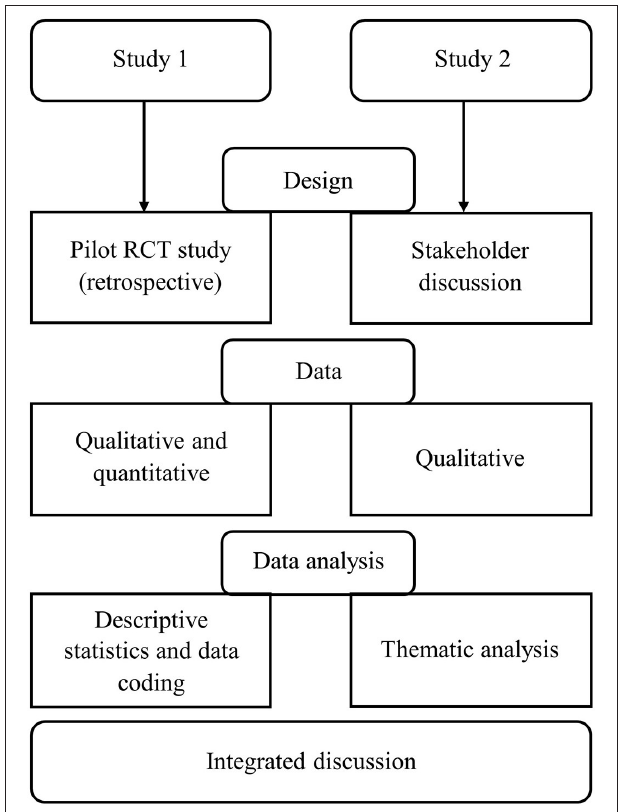
FIGURE 1 | Process flow of the studies